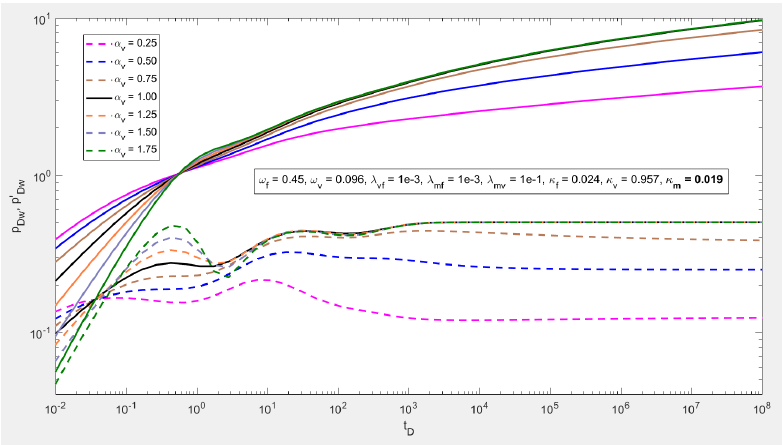
Figure 8. Effects of considering anomalous flow only in the vugular system, α f = 1, α m = 1.